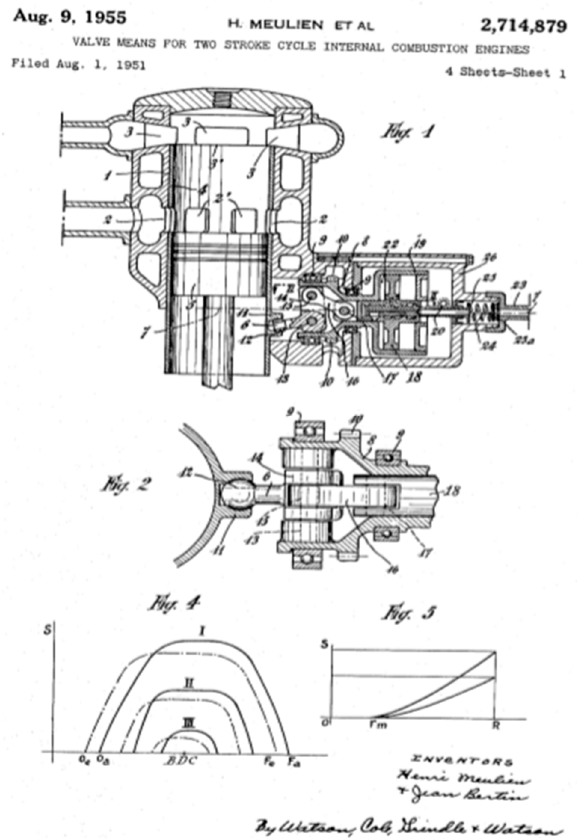
Figure 16. H. Meulien et al. SNECMA 1 August 1951, Valve US 2714879. Reproduced with permis- sion e 1951.